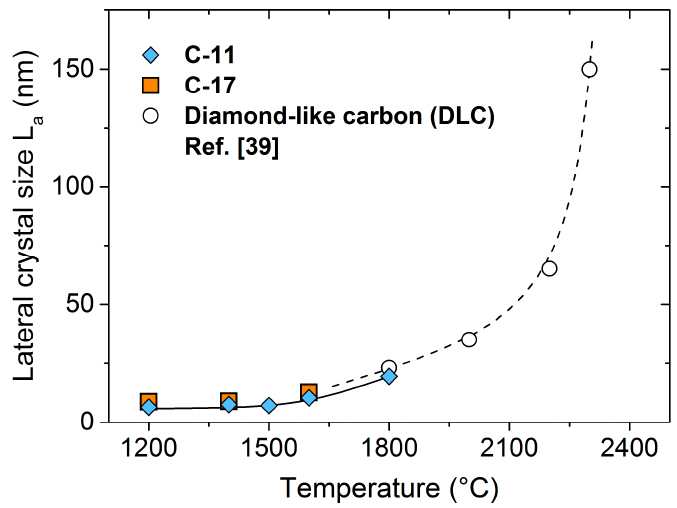
Figure 2. Lateral crystal size L a of carbon as a function of the temperature. Open points: Adapted from ref. [39], dashed line: guideline for the eye.